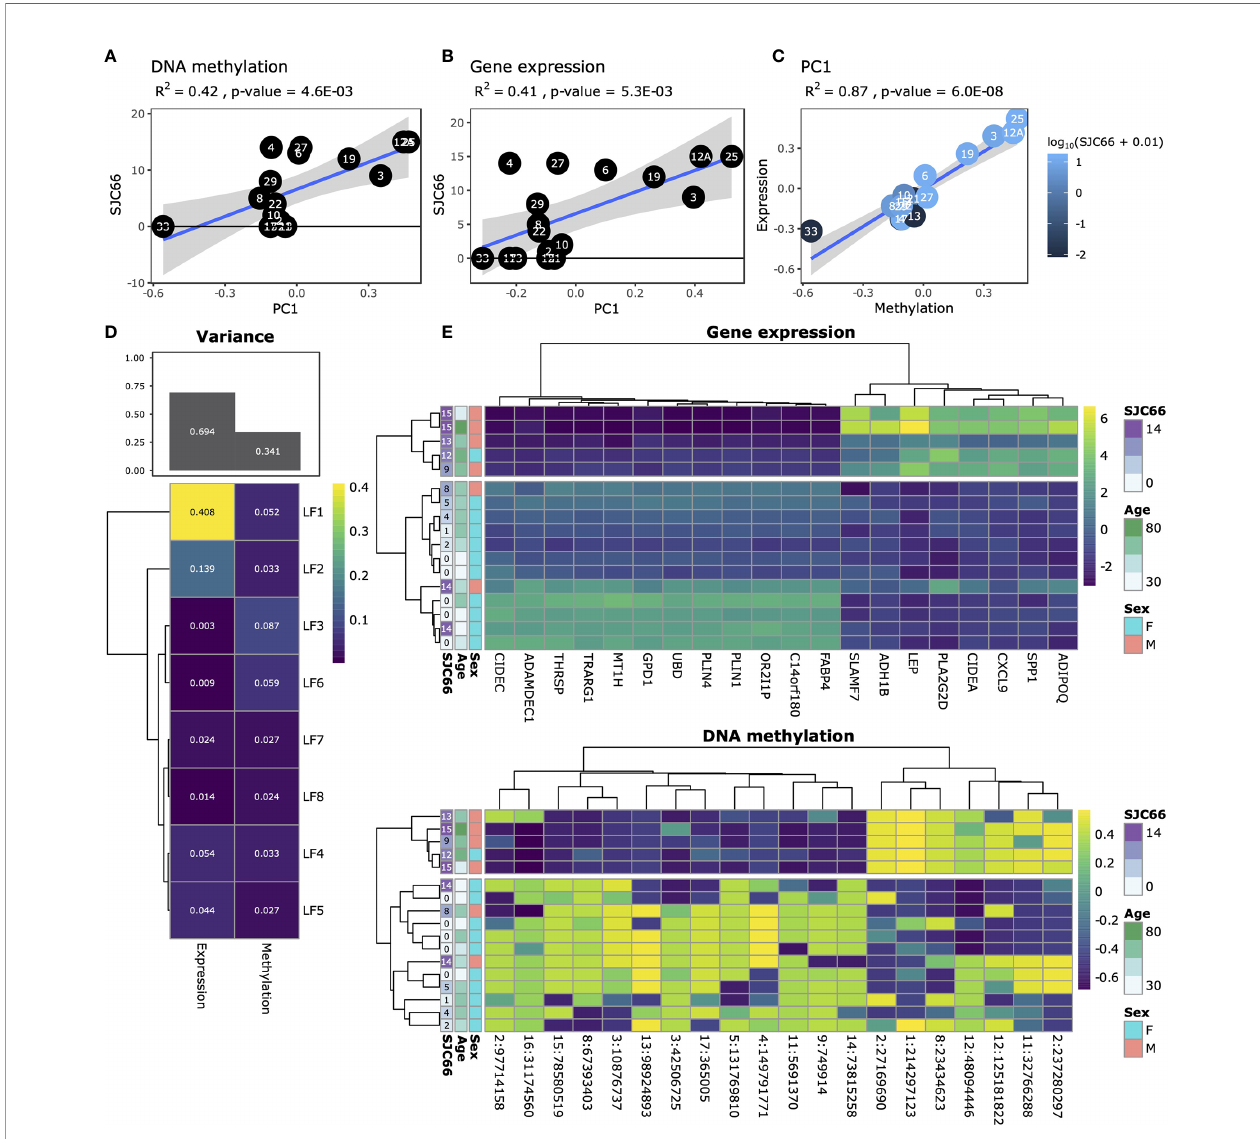
FIGURE 1 | Exploratory analysis. Analysis of SJC66 regressed onto the fi rst principal component of (A) DNA methylation and (B) gene expression annotated with the Pearson r-squared (R 2 ) and the p -value. (C) Comparison of the fi rst principal components for DNA methylation on the x-axis and gene expression together coloured for SJC66. Trendlines represent the mean and 95% con fi dence intervals. (D) Results obtained from multi-omics factor analysis, where the fi gure at the top depicts a bar chart representing the percentage variance explained by gene expression and DNA methylation, which has been decomposed into the separate latent factors (LF) at the bottom. (E) Decomposition of the variance observed for LF1 into the loadings assigned by MOFA to the top 20 weighted features for gene expression (top; colours represent log 2 (count)) and DNA methylation (bottom; colours represent percentage